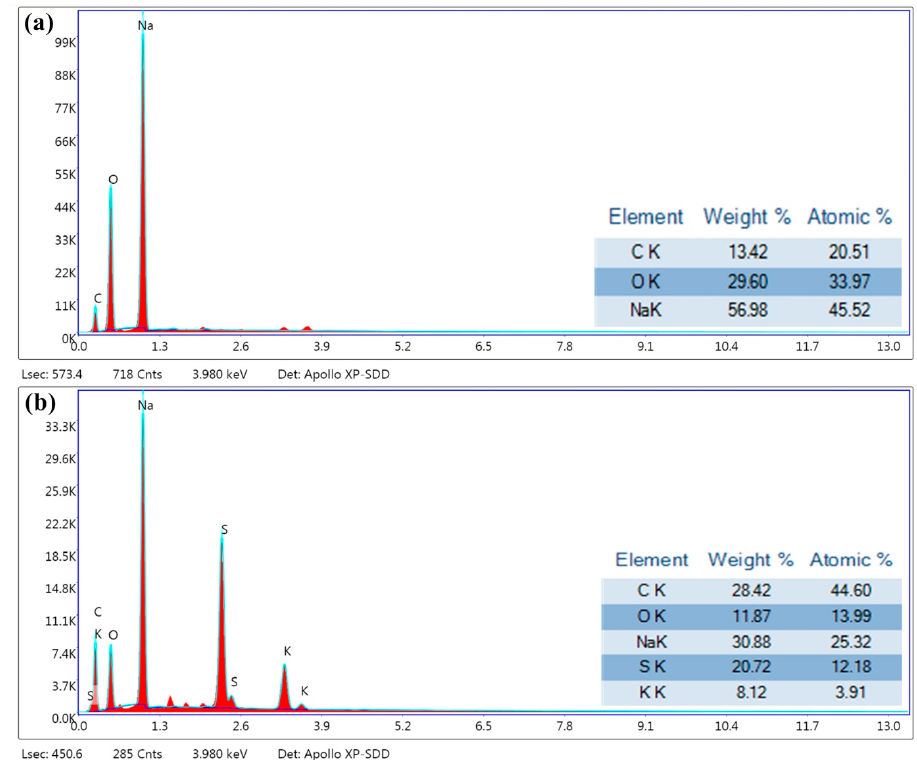
Figure 4. EDAX mapping results of the surface of the ( a ) charged Na anode and the ( b ) discharged SPAN composite cathode in the hybrid battery after 20